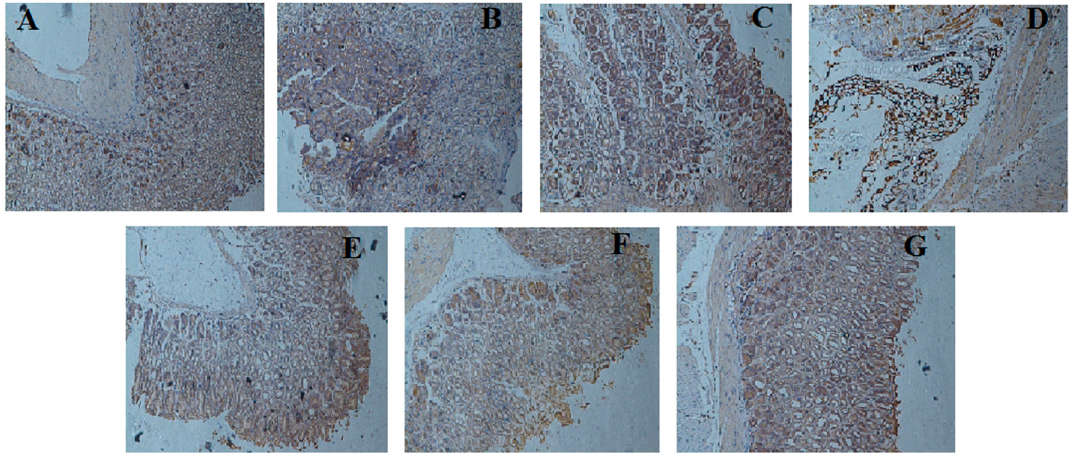
Figure 7. Immunohistochemical staining for the determination of NF- κ Bp65 protein expression in gastric mucosa. ( A ) Control; ( B ) model; ( C ) ethanol + OME 20 mg/kg; ( D ) ethanol + LCA 50 mg/kg; ( E ) ethanol + LCA 100 mg/kg; ( F ) ethanol + LCA 200 mg/kg; ( G ) ethanol + LCA 400 mg/kg. (Original magnification 100×).